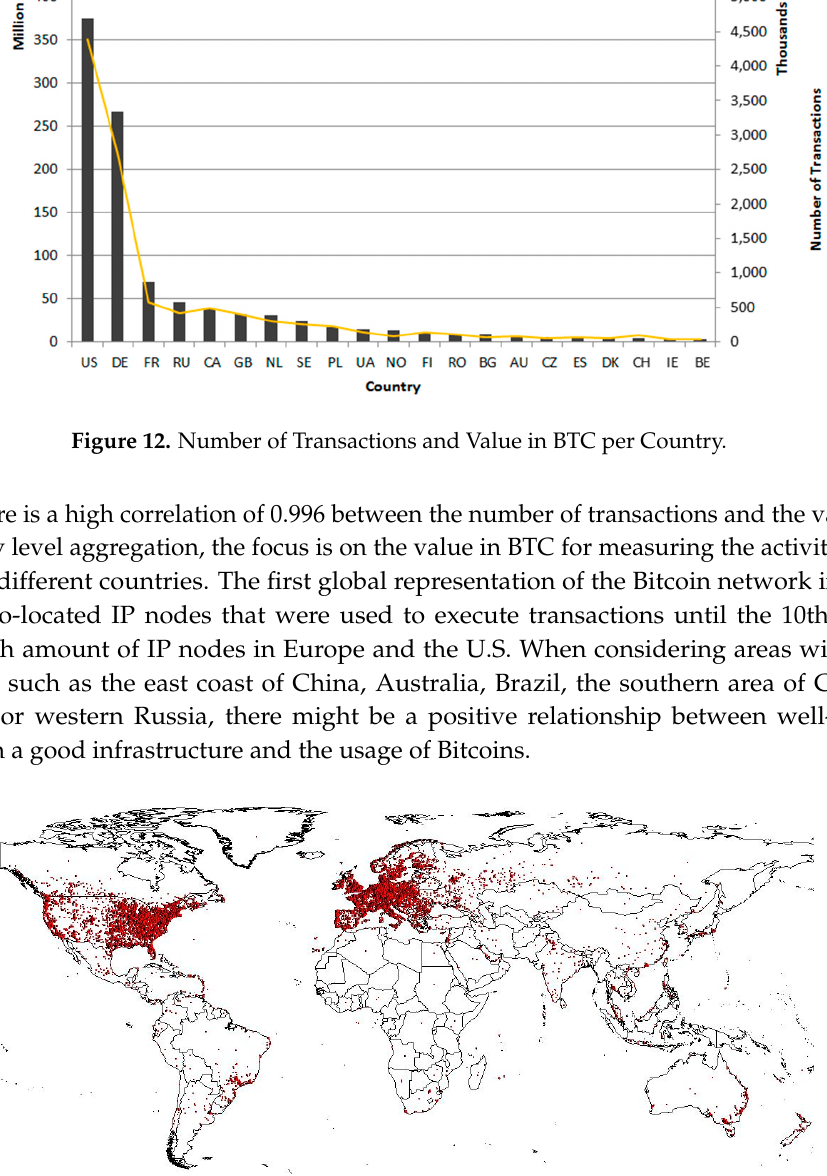
Figure 11. Composite of Businesses over Time (Value in BTC).